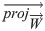
Simulation of the fall of rigid body, representing θ the angle to the horizontal, COP the Centre of Pressure, CM the Centre of Mass locus, the projW→→ is the weight projection to the CM-COP direction, W→is the rigid body weight, R→Passiveis the ground reaction force, and Fco→ is the centrifugal force.